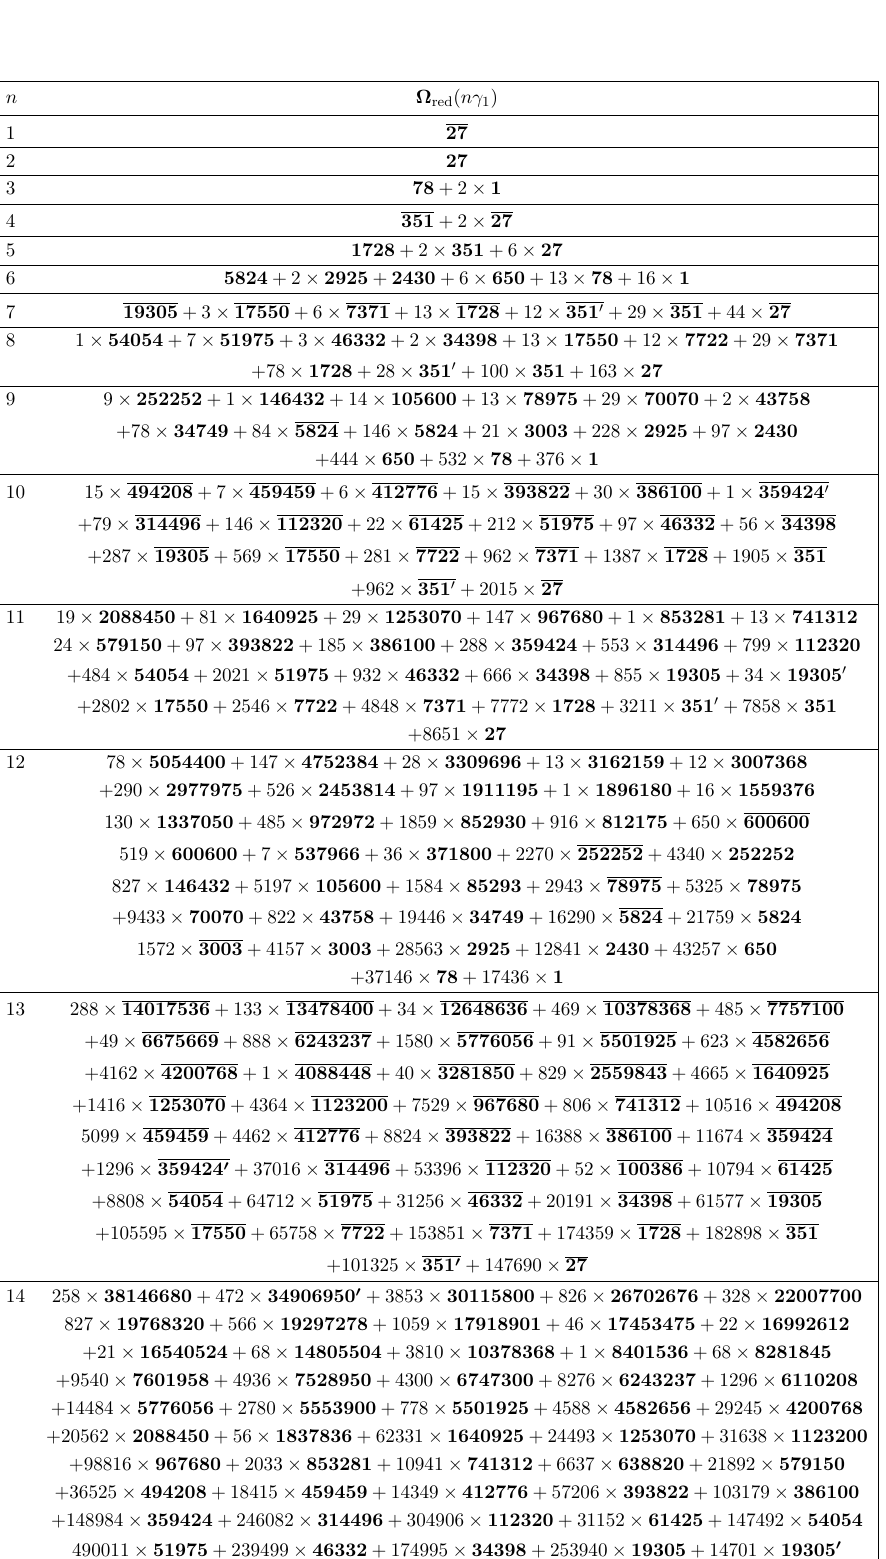
Table 4 . Reduced BPS indices for the Minahan-Nemeschansky E 6